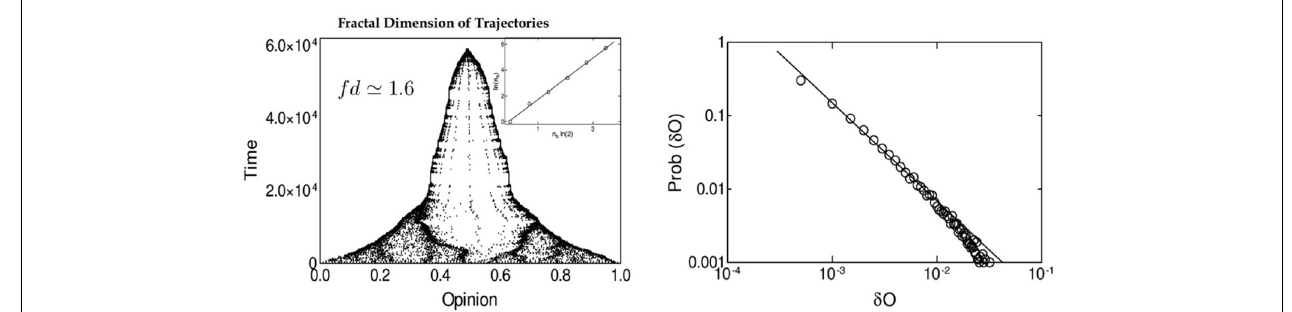
FIGURE 4 | Complex dynamics features. Among the interesting features suggesting the existence of a self organizing complex dynamics beyond the systems studied by our model, the figures above report probably the most important. On the left the agents’ trajectories for a single simulation are reported and analyzed by mean of the box method, reporting a fractal